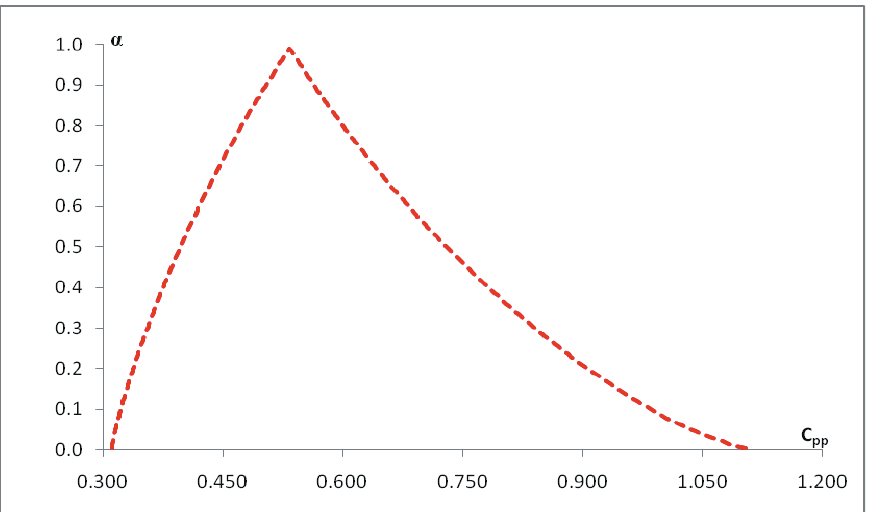
C for for Supplier-C pp